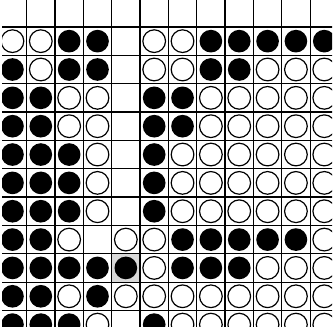
Figure 48. WHITE